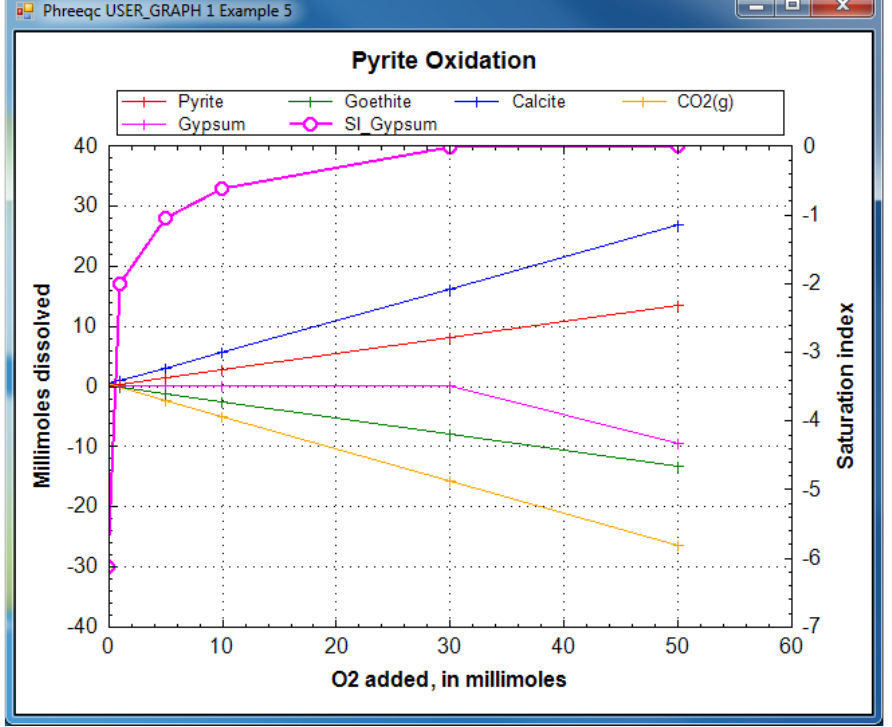
Figure 6. Reaction of pyrite, calcite, and goethite in a beaker filled with 1 kilogram water to which oxygen is added in fixed steps. Pyrite and calcite dissolve, goethite precipitates, and gypsum starts to precipitate when more than 30 millimoles of O 2 is added to the beaker. Carbon dioxide, originating from calcite, is lost from the acidifying solution, which remains in equilibrium with the atmospheric partial